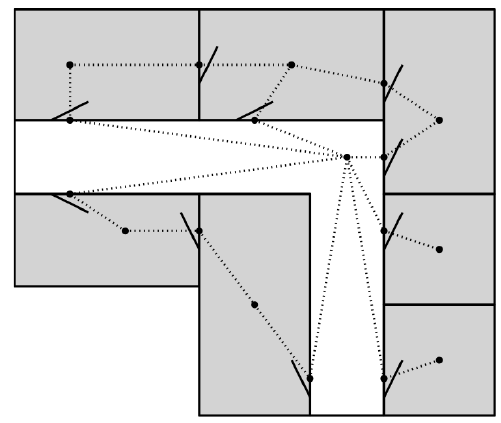
Figure 1. An example of a thick wall Connectivity NRG (dotted line) for a floor